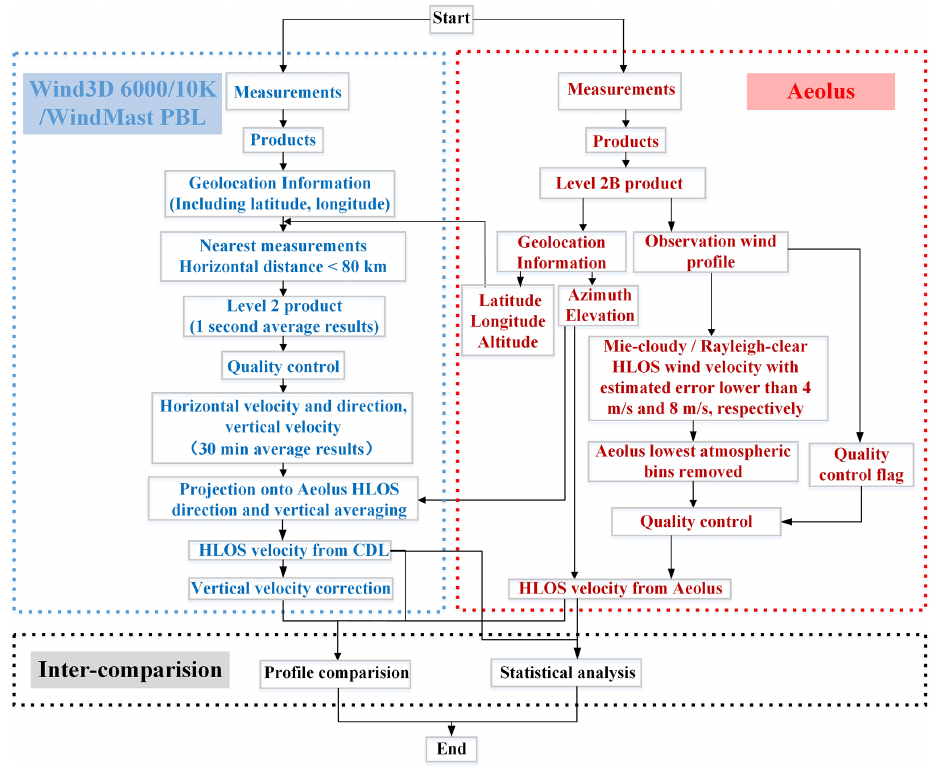
Figure 4. Sketch of the comparison between CDLs and Aeolus in the atmospheric boundary layer and the lower troposphere.